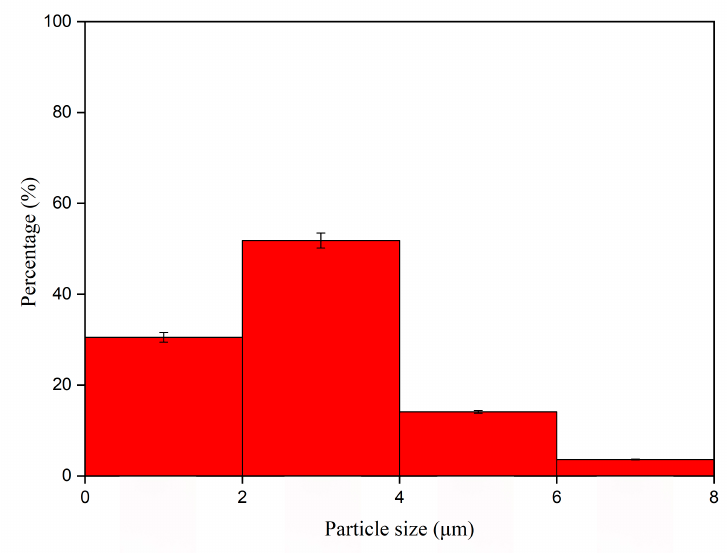
Figure 4. Particle size distribution of microcapsules.